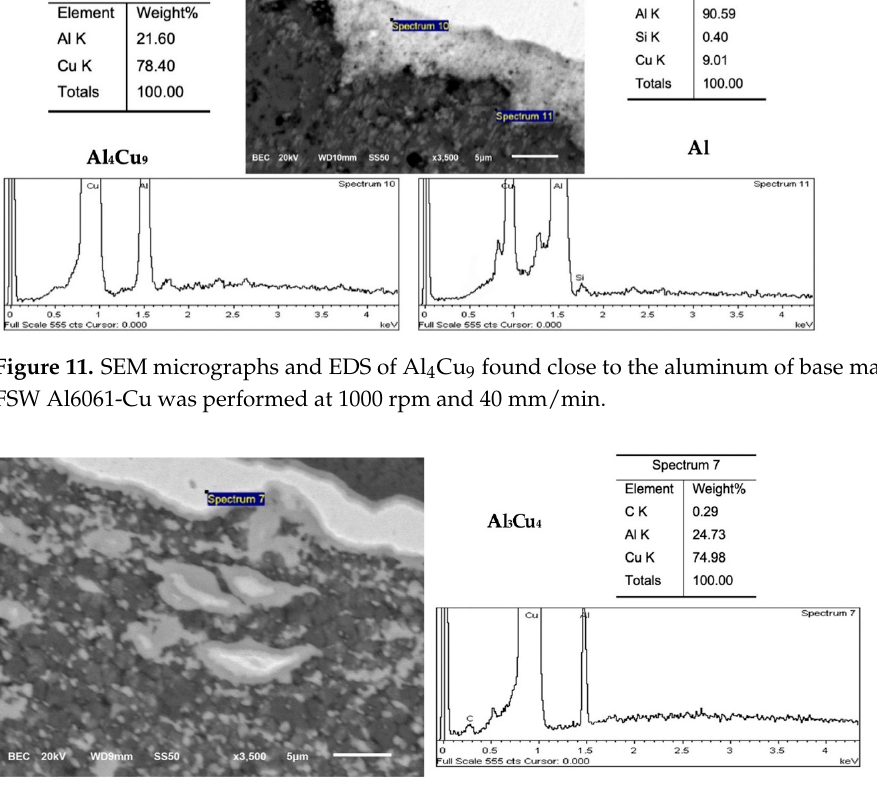
Figure 12. SEM micrographs and EDS of Al 3 Cu 4 found close to the aluminum of base material, the FSW Al6061-Cu was performed at 1000 rpm and 20 mm/min.